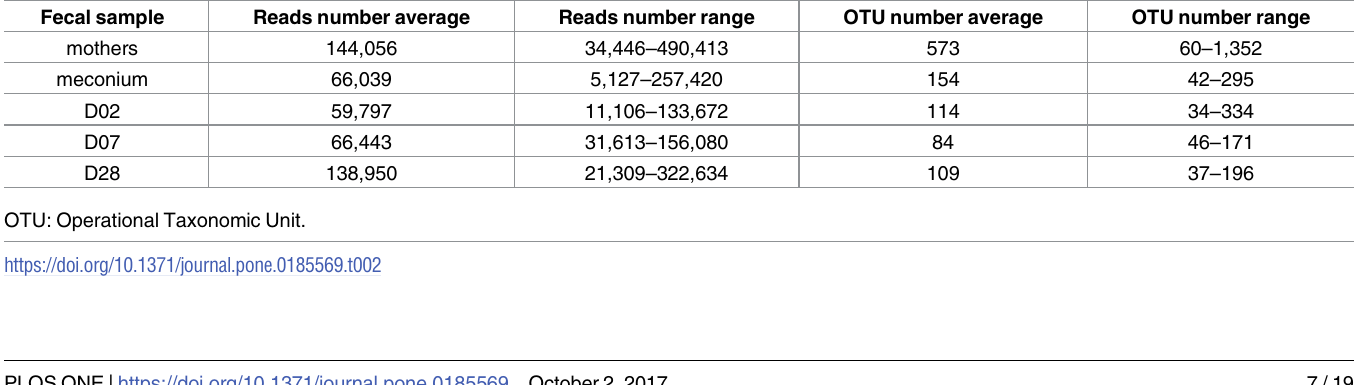
Table 2. Averagesand ranges of the reads numbers and OTU numbers for mothers, meconium, D02, D07 and D28. Fecal sample